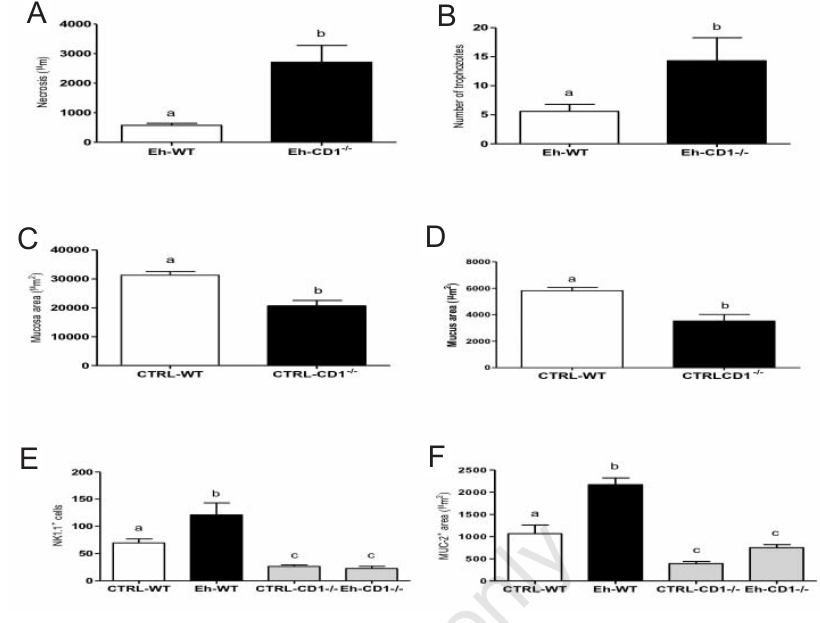
Figure 3. Morphometric analysis of mucosa, trophozoite, natural killer 1.1 + T cell and MUC-2 in caecal mucosa of C57BL/6 wild type and C57BL/6CD1 -/- mice inoculated or not with Entamoeba histolytica . A) Extension of necrotic mucosa; B) Number of tropho- zoites; C) Area of caecal mucosa; D) Area of mucus in the caecal mucosa; E) Number of natural killer 1.1 + lymphocytes; F) Expression of MUC-2 in the caecal mucosa of C57BL/6WT and C57BL/6CD1 -/- control mice and infected with Entamoeba histolytica . (n=10 per group). Data are shown as the mean ± standard error. P<0.05.